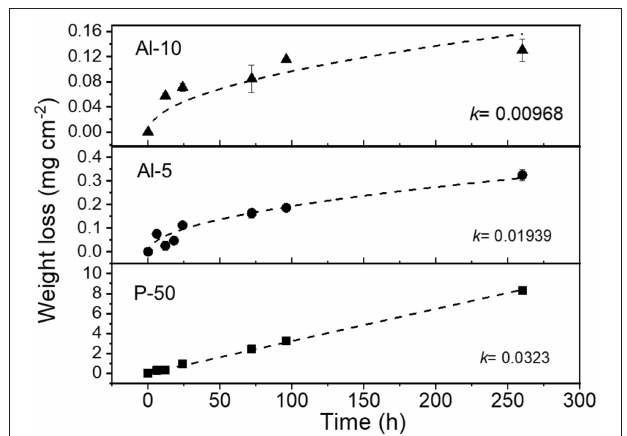
FIGURE 11 | Normalized weight loss (mg cm − 2 ) of the metaphosphate (P50) glass and CaO-Al 2 O 3 -P 2 O 5 (Al5 and Al10) glass along with dissolution rate parameter ( k ) in deionized water as a function of time. The lines are drawn as guide for the